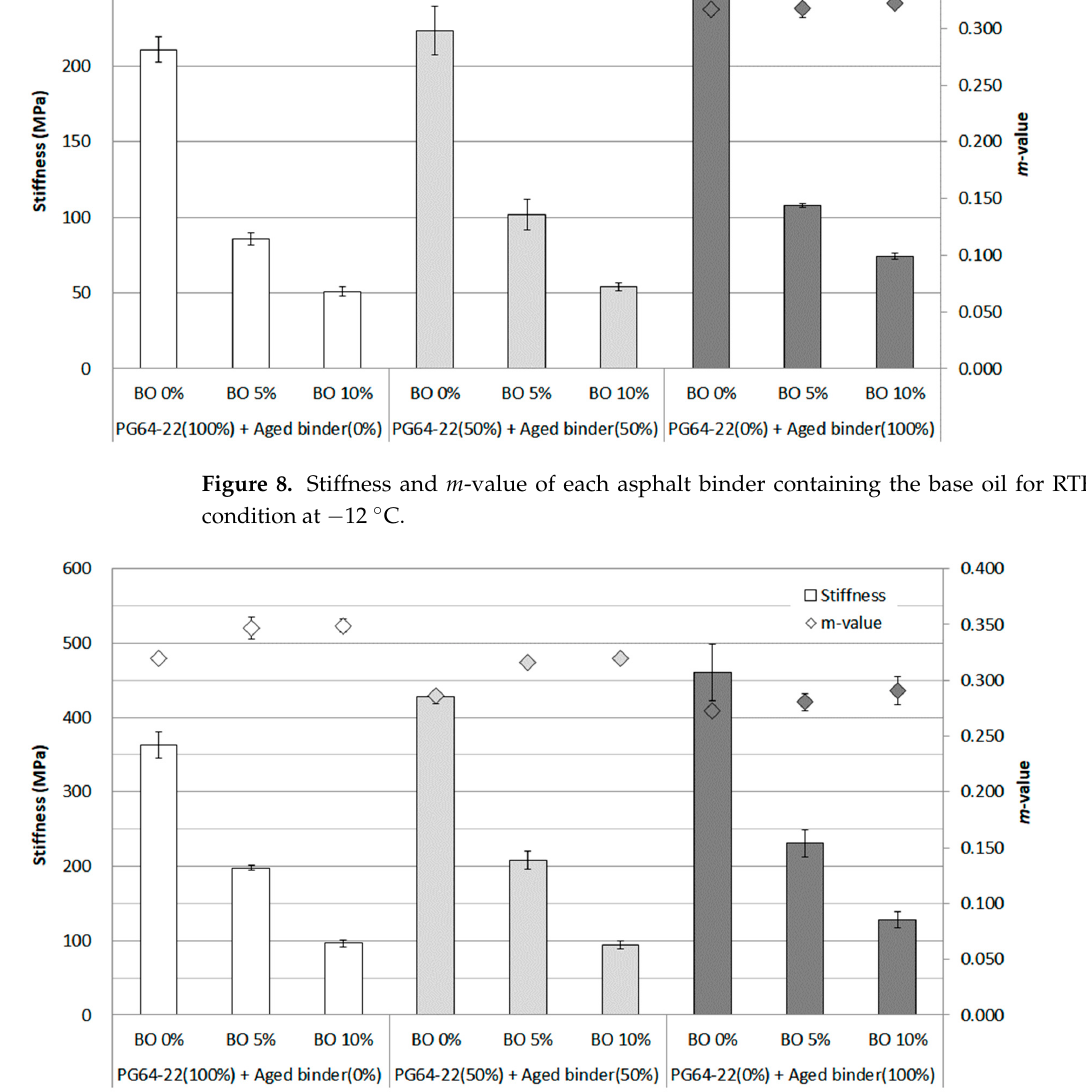
Figure 9. Stiffness and m -value of each asphalt binder containing the base oil for RTFO + PAV condition at − 18 °C.